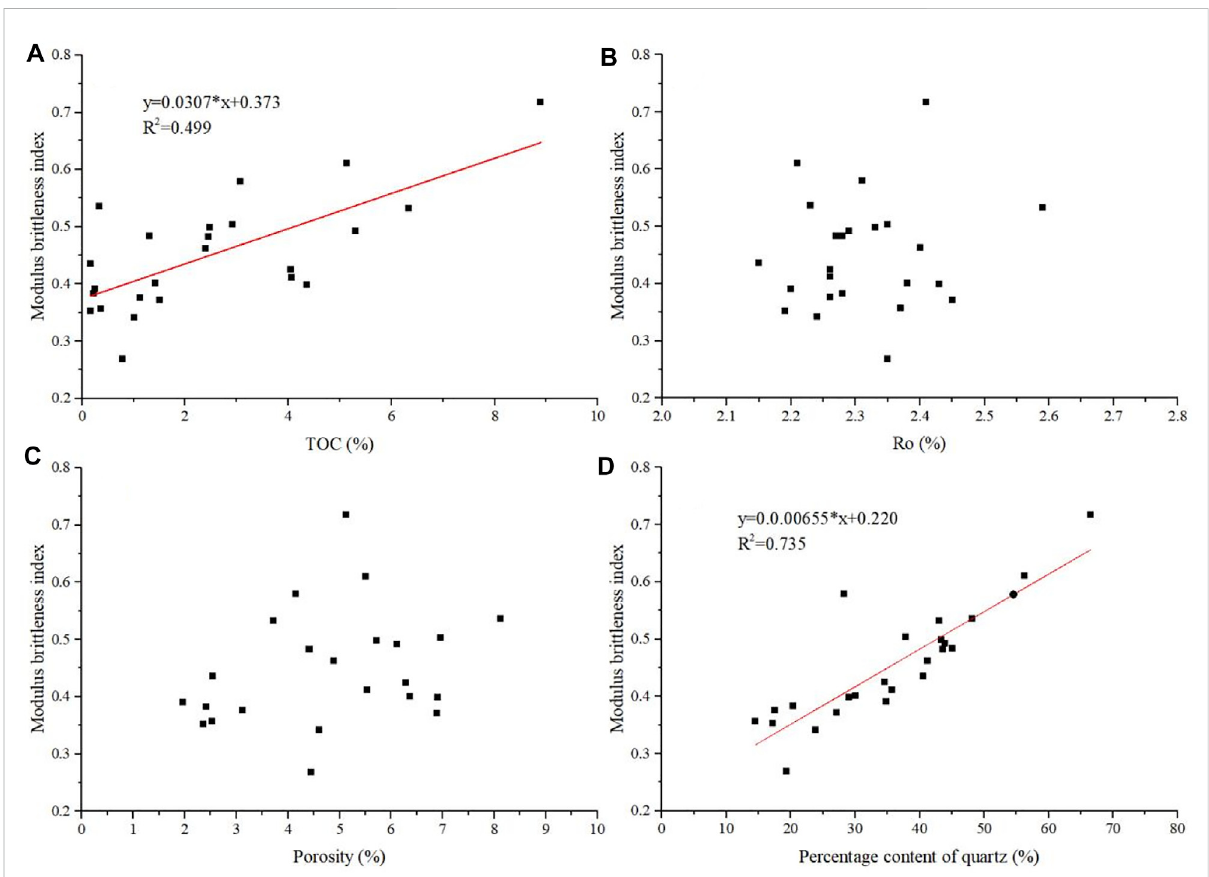
FIGURE 10 RelationshipbetweenthemodulusbrittlenessindexandTOC (A) ,R o (B) ,porosity (C) ,andquartzcontent (D) oftheLongmaxiFormationshalein the study area,